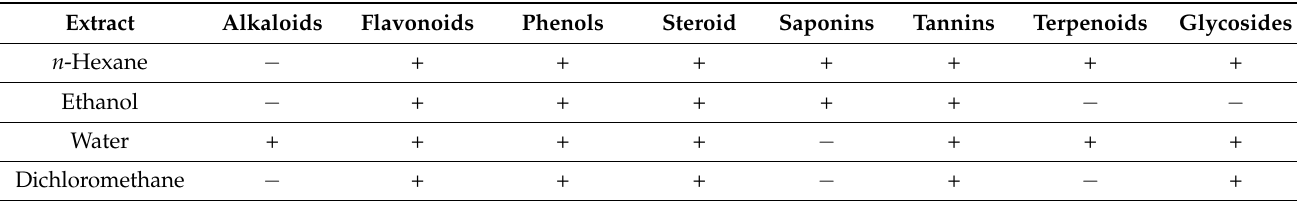
Table 3. Qualitative phytochemical screening of various O. basilicum leaf extracts.